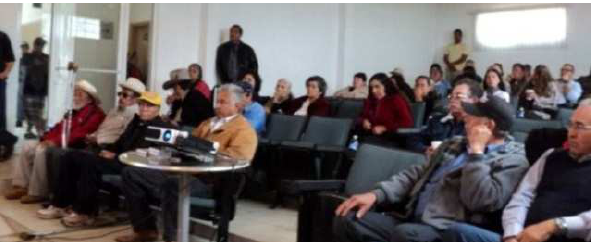
Fig. 14. Meeting with the ejidatarios (taked from MEZA- UABC